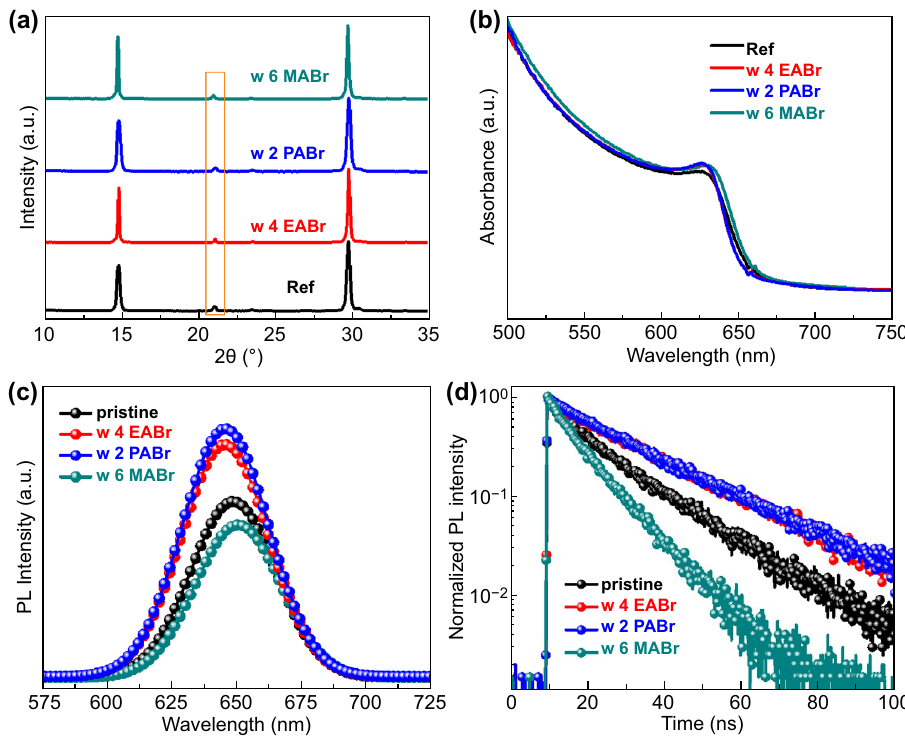
Fig. 3 a XRD pattern, b UV–Vis absorption spectra, c PL spectra, and d TRPL spectra of Ref, 4 mg mL −1 EABr, 2 mg mL −1 PABr and 6 mg mL −1 MABr-treated